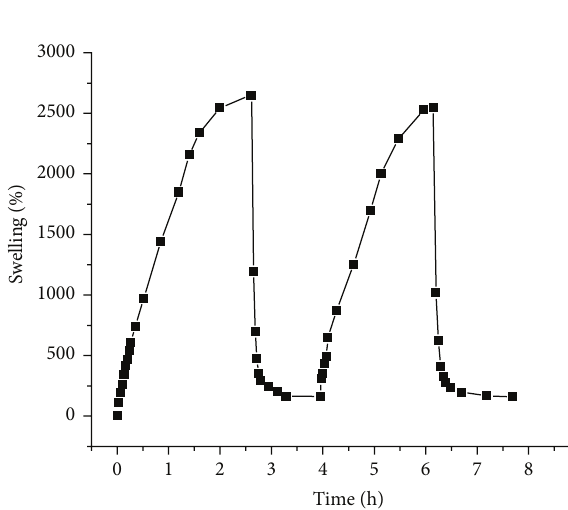
Figure 8: Dynamic swelling (pH 12.0)/deswelling (pH 2.0) behavior of PAcHP hydrogels obtained from bulk